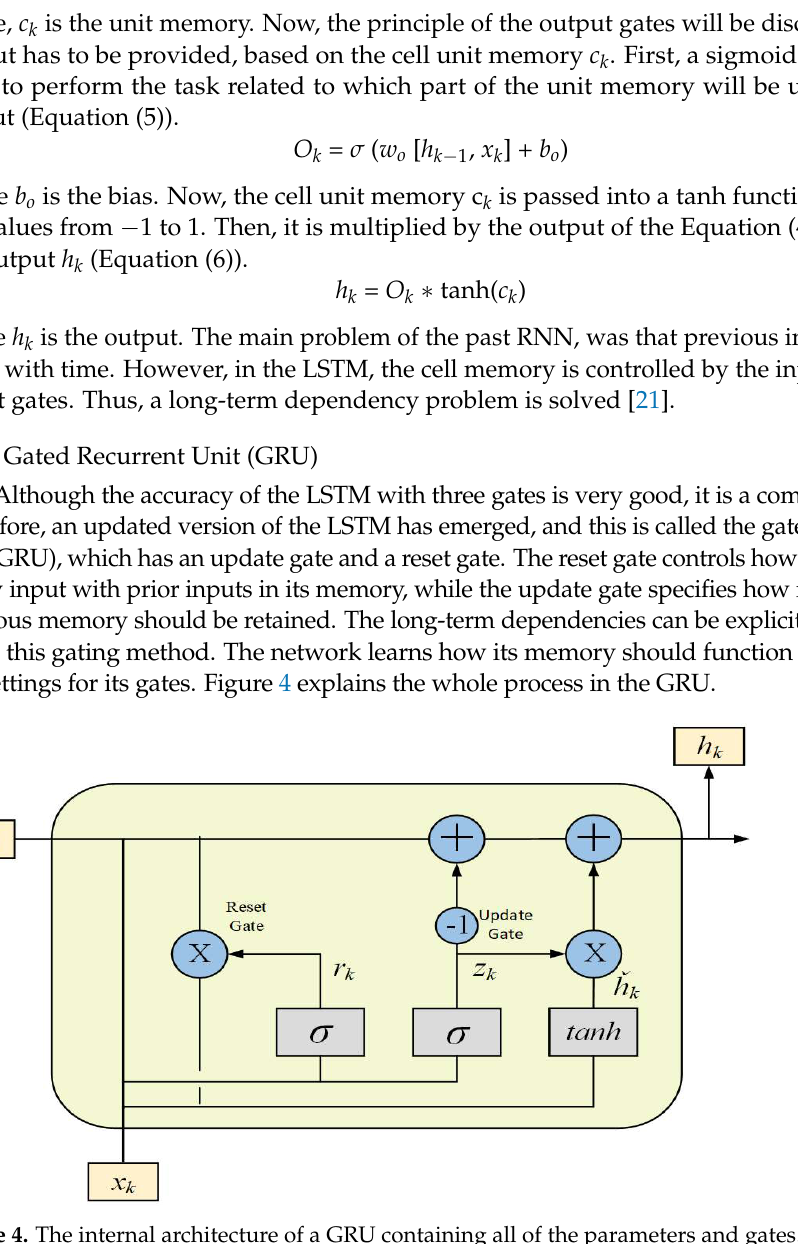
Figure 4. The internal architecture of a GRU containing all of the parameters and gates. The reset gate is denoted by ‘ r ’ and the update gate is denoted by ‘ z ’. Equations (7)– (10) represent the whole GRU process [22]. The GRU reduces the complexity of the LSTM and works very well with small datasets.